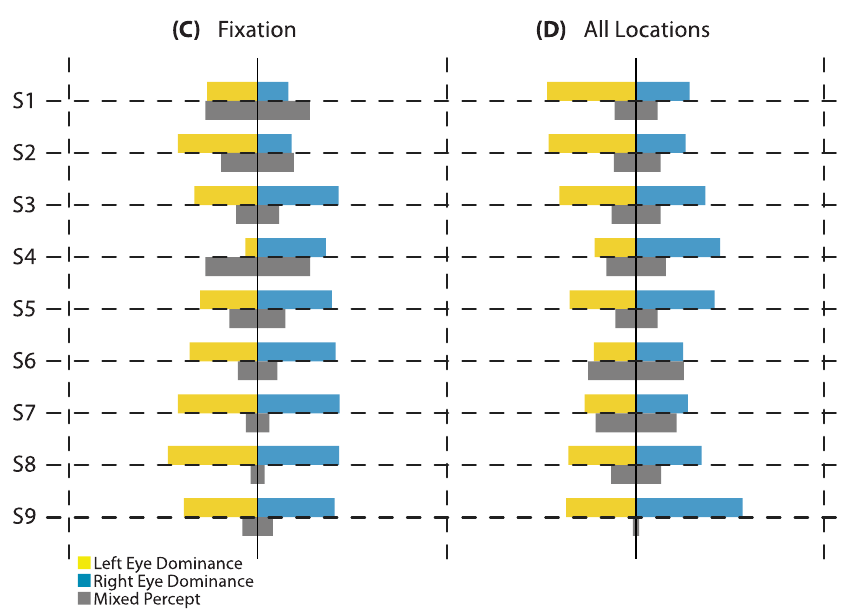
Figure 2. Eye Dominance: The proportion of right eye and left eye dominance at onset shows a stronger bias at fixation ( A ) than when averaging over all locations in and around the fovea ( B ). During sustained rivalry there is less bias, both at fixation ( C ) and over all locations ( D ), than at the onset of